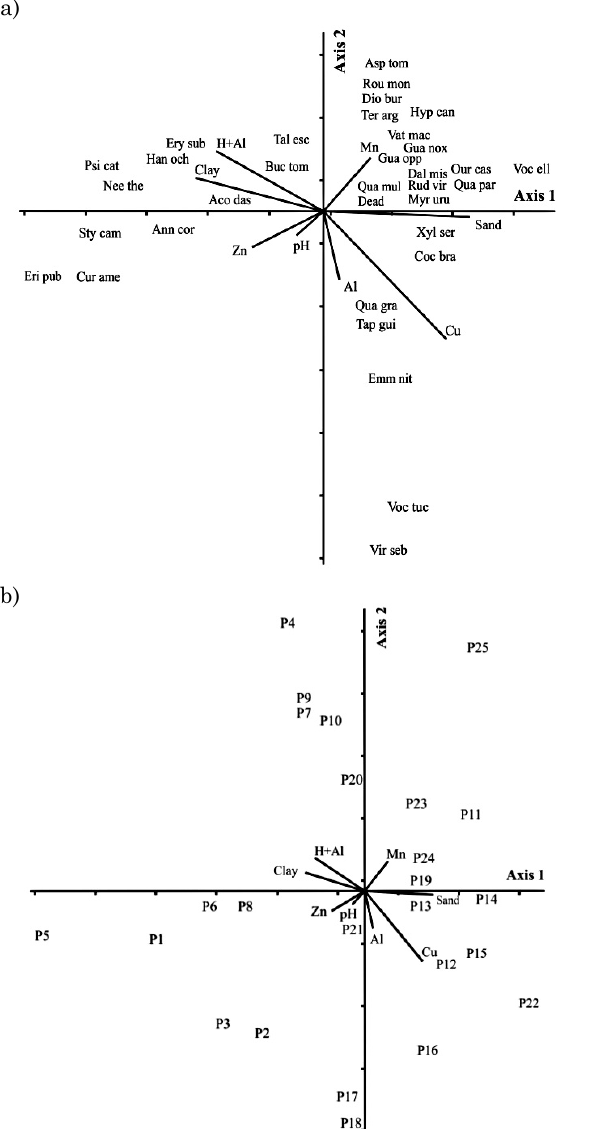
Figure 1. Ordination plots for species (a) and plots (b) resulting from canonical correspondence analysis based on the density distribution of 34 tree and shrub species represented by at least 15 or more plants in the cerrado of Ouroana, Goiás. Edaphic variables are represented by the following vectors: h+al: potential acidity, cu: copper, al: aluminum, zn: zinc, Mn: manganese, clay, sand and pH: hydrogen ion concentration.